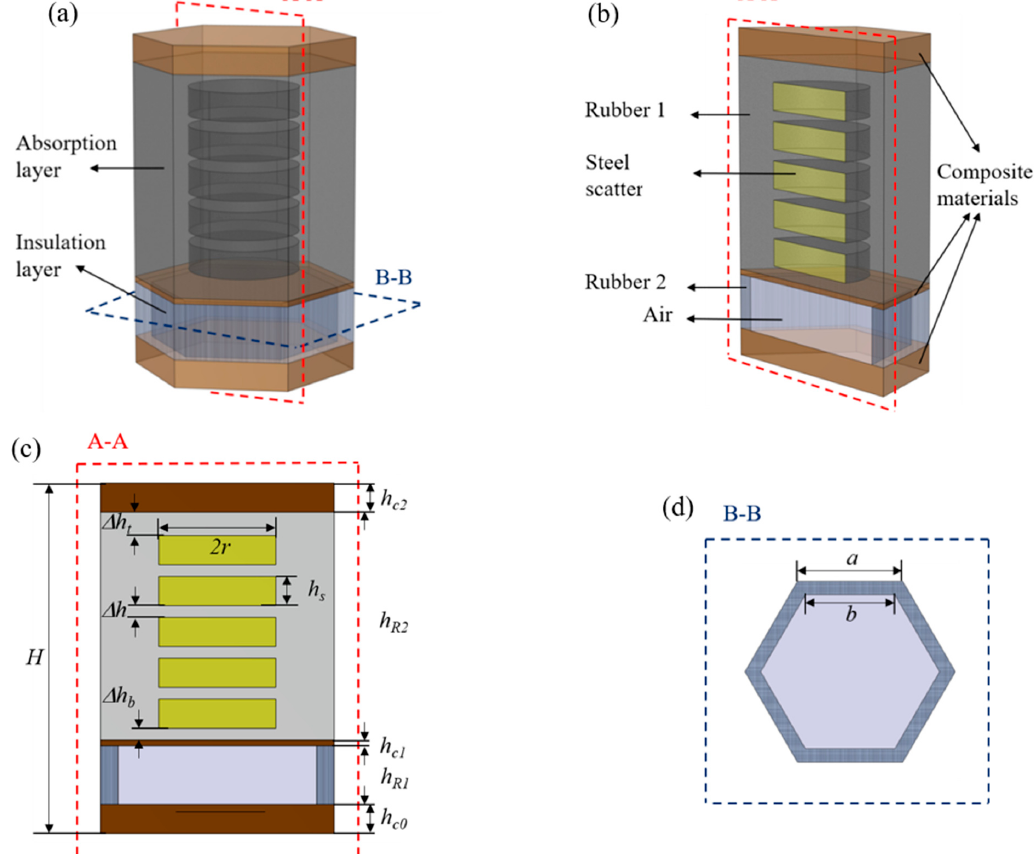
Figure 1. ( a ) Depiction of the hexagonal structural unit; ( b ) Schematic diagram of the structural unit; ( c , d ) Geometry and position distribution of each component ( H = 60 mm, ∆ h t = 4 mm, ∆ h b = 2 mm, ∆ h = 2 mm, h s = 5 mm, r = 10 mm, h c 0 = 5 mm, h R 1 = 10 mm, h c 1 = 1 mm, h R 2 = 39 mm, h c 2 = 5 mm, a = 20 mm, b = 17 mm). Table 1. The property parameters of the materials. Density (kg/m 3 ) Young’s Modulus (Pa) Shear Modulus (Pa) Poisson’s Ratio Loss Factor